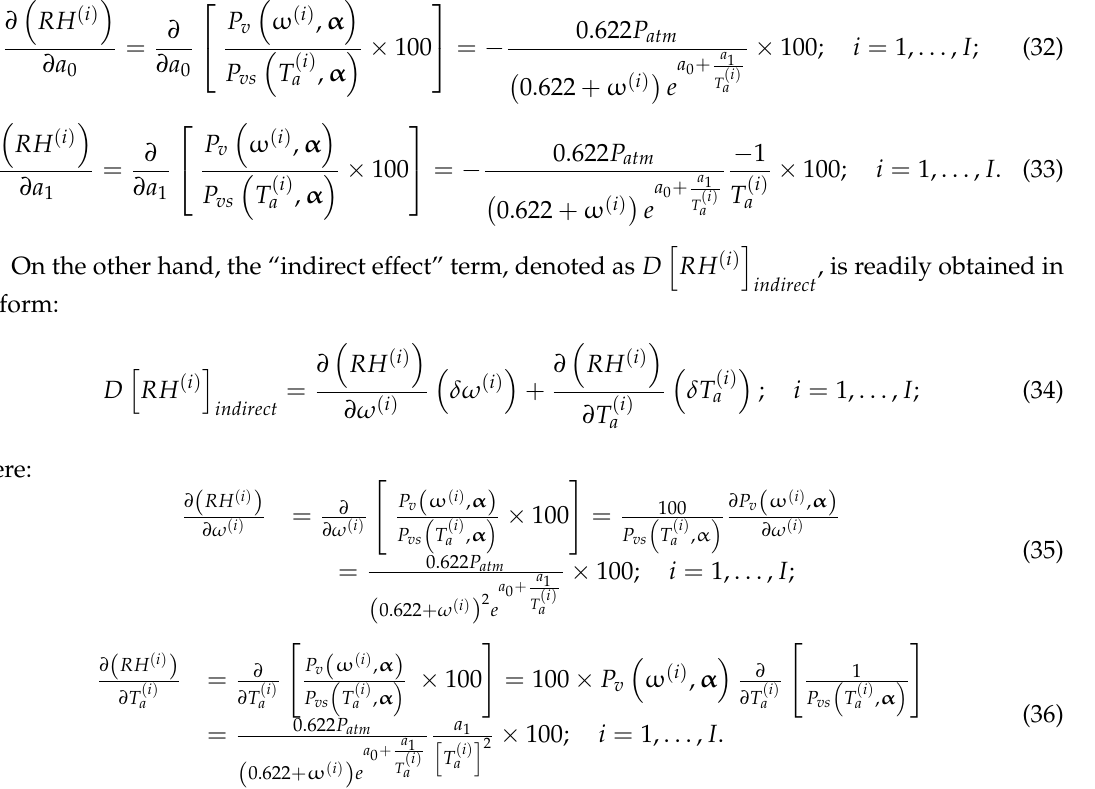
( 1 ) (cid:44) T ( 50 ) a , R w ,